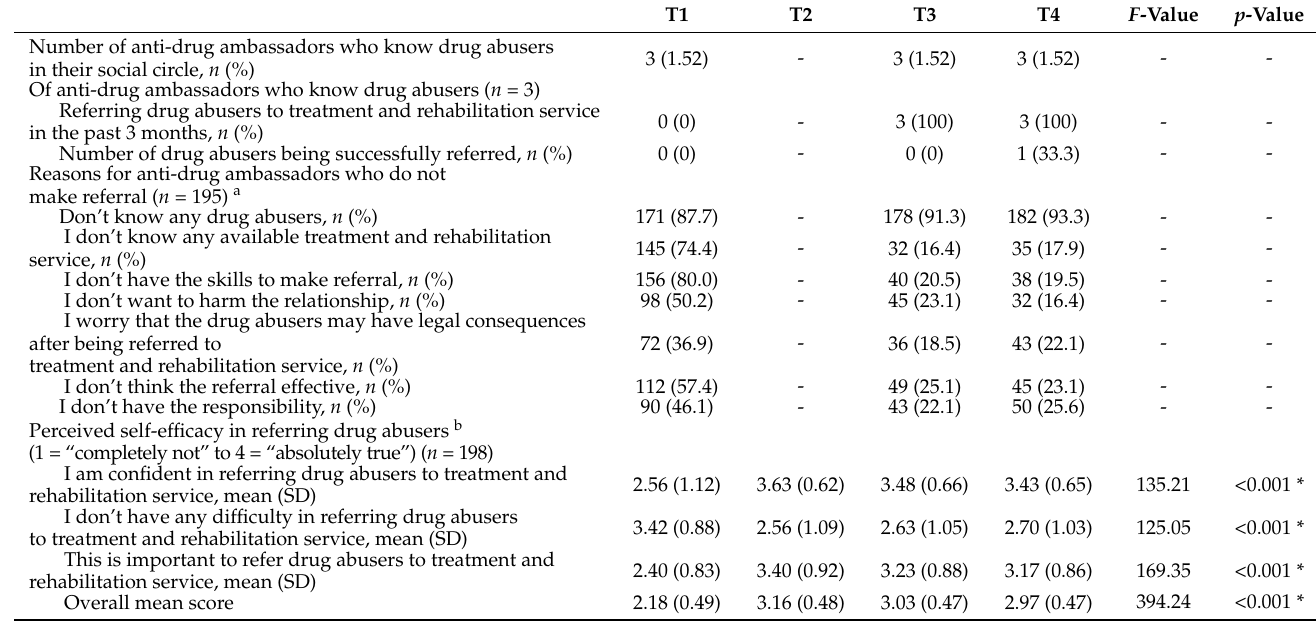
Table 4. Changes in anti-drug practices among anti-drug ambassadors ( n = 198).